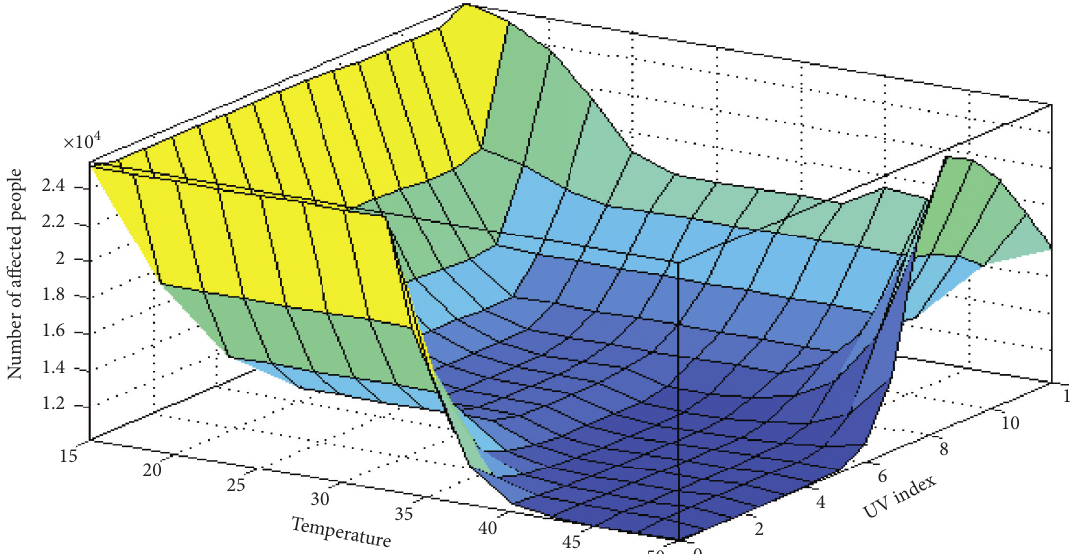
Figure 5: Relationship between temperature, UVI, and the number of affected people.